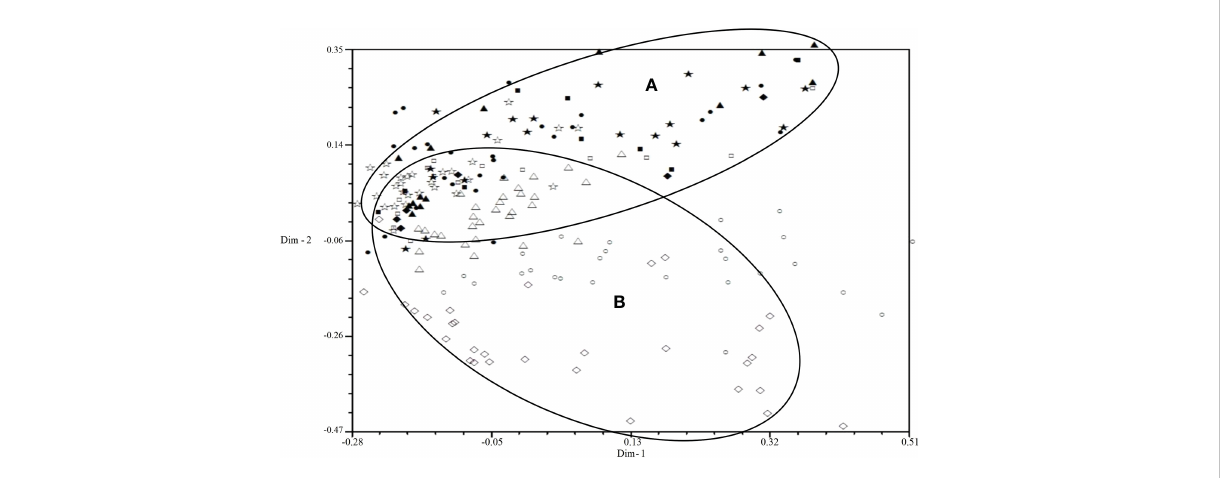
FIGURE 4 Two-dimensional plot of principal coordinates analysis of Puccinia triticina based on EST-SSR polymorphism. ◼ , Year 2001; ▲ , Year 2002; ◆ , Year 2003; (cid:129) , Year 2004; ★ , Year 2005; □ , Year 2006; ○ , Year 2007; △ , Year 2008; ◇ , Year 2009; ☆ , Year 2010. Area A contains most isolates from 2001-2006 and area B contains most isolates from